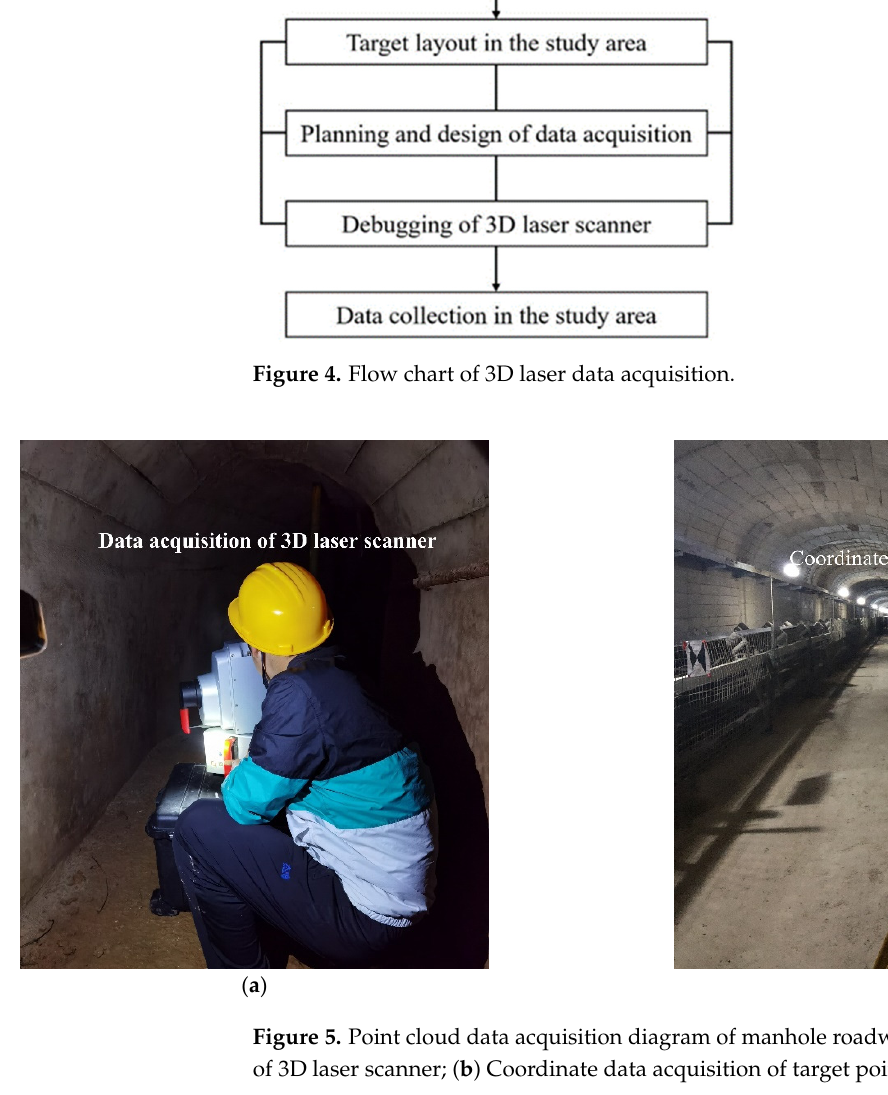
Figure 4. Flow chart of 3D laser data acquisition.